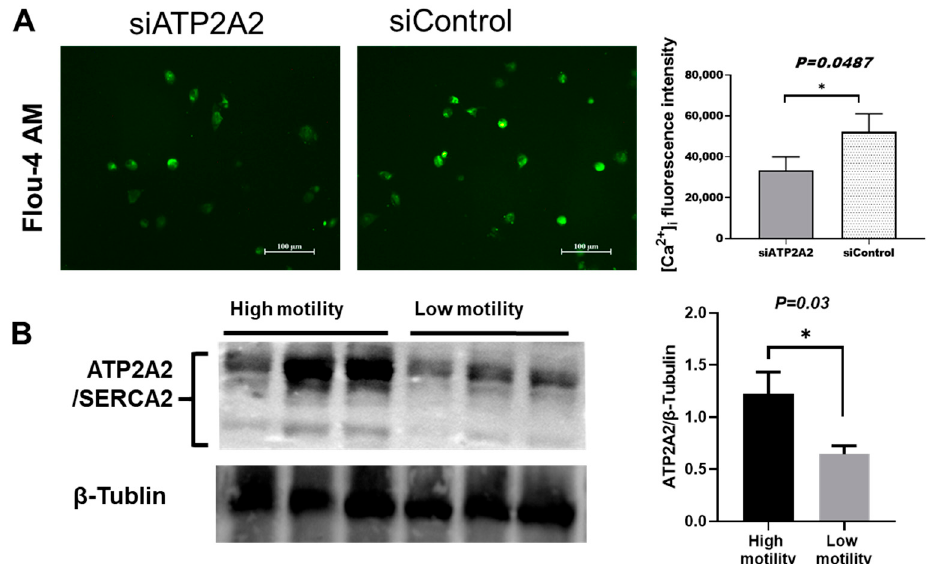
Figure 4. ATP2A2 regulated calcium signaling in Leydig cells ( A ) and different expression in in high ‐ and low ‐ motility sperms ( B ) ( * p < 0.05